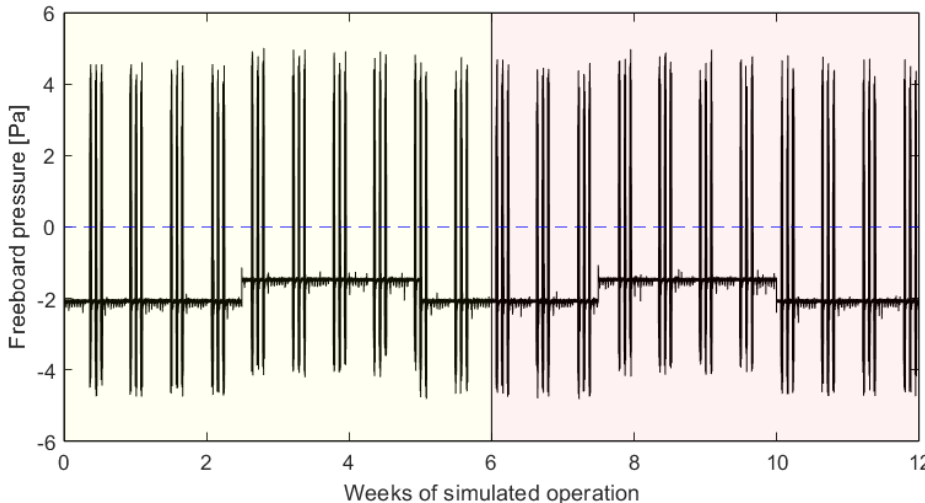
Figure 6. Illustration of the simulated process dataset partitioned into separate training (gold) and testing (red) datasets. The dashed blue line indicates zero gauge pressure. Note that all variables in 𝐗 𝑡 are partitioned in the same way, not just the freeboard pressure.